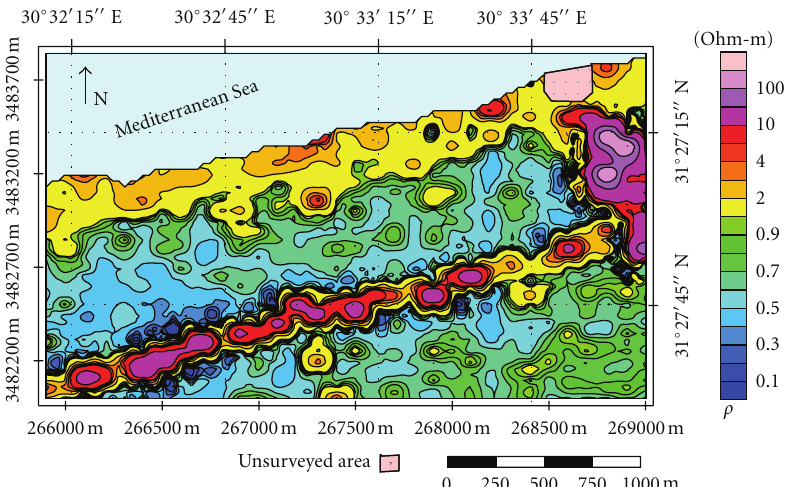
Figure 12: Filled colour contour map of the electric resistivity ( ρ ) laboratory measurements, Koam Mashaal area, East Rosetta, Mediterranean Sea Coast, Northern Egypt. Contour interval = 0.1 Ohm · m.